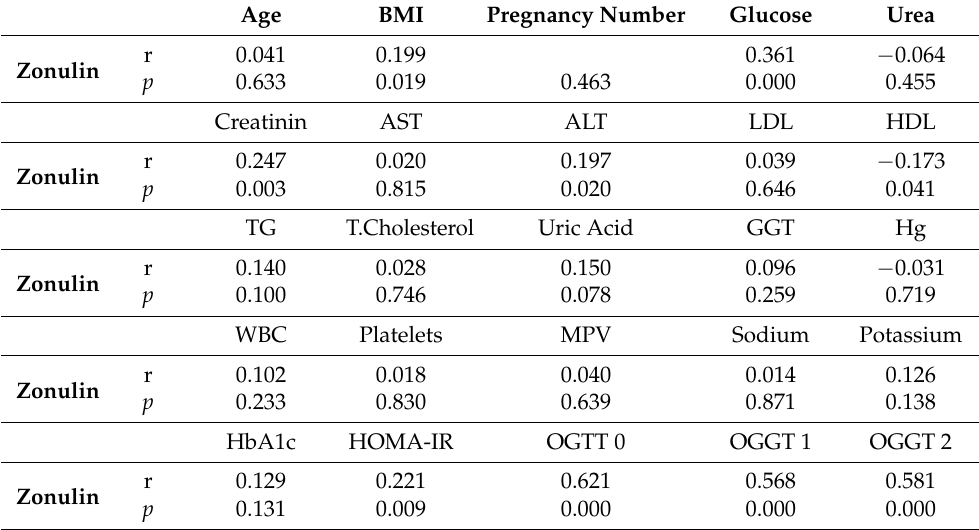
Table 3. Results of the Spearman correlation